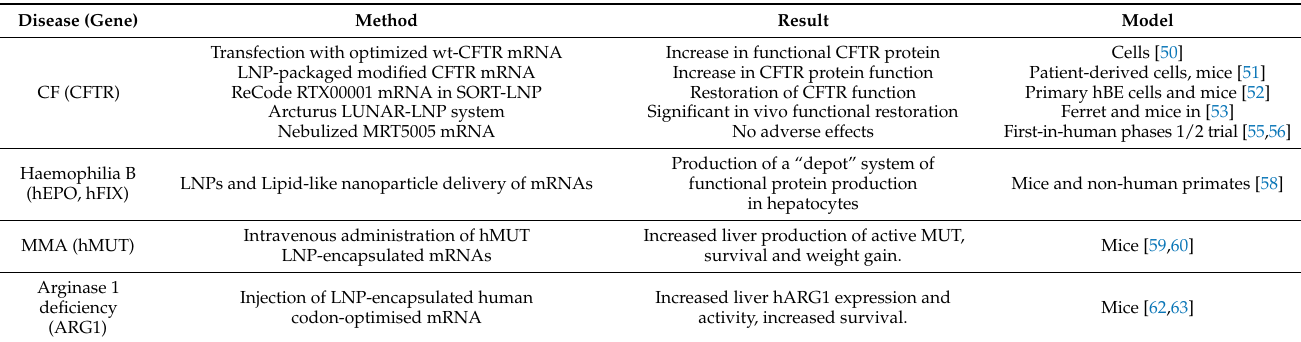
Table 2. Summary of important advances in mRNA therapeutics for monogenic